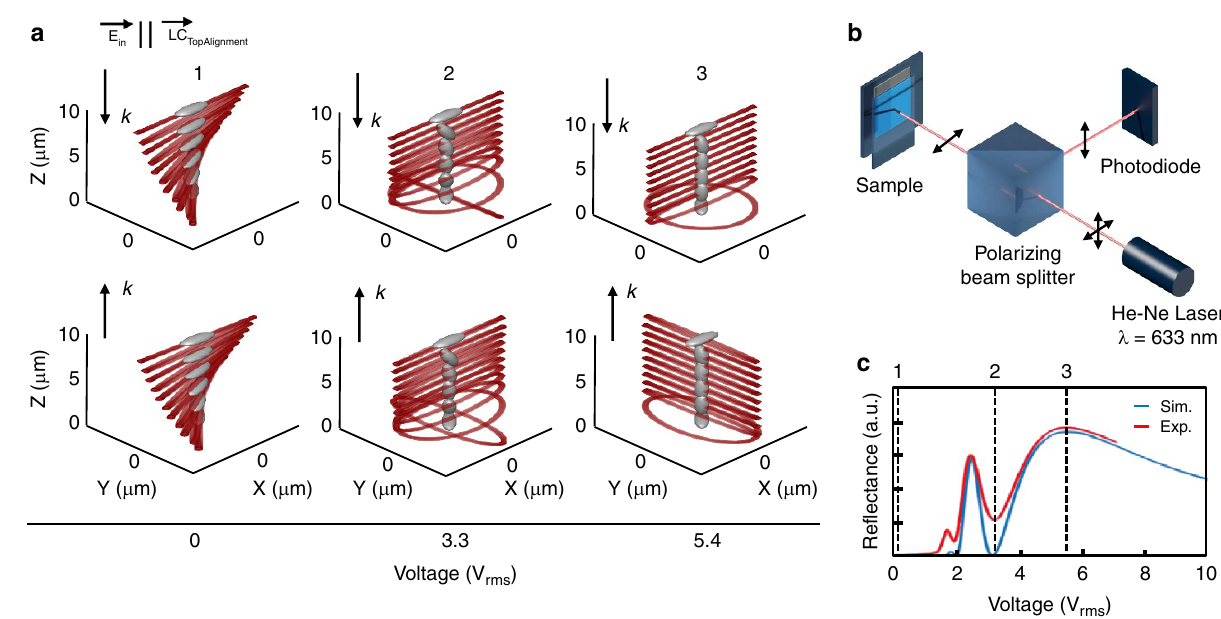
Figure 3 | Liquid crystal orientation and polarization rotation. ( a ) Schematics of the liquid crystal and light polarization throughout the cell and at selected voltages. Liquid crystals are not drawn to scale and are down sampled from the FEM simulations. ( b ) Experimental setup to verify liquid crystal orientation throughout cell and ( c ) results. Dotted black lines and labels correspond to the selected fields shown in a